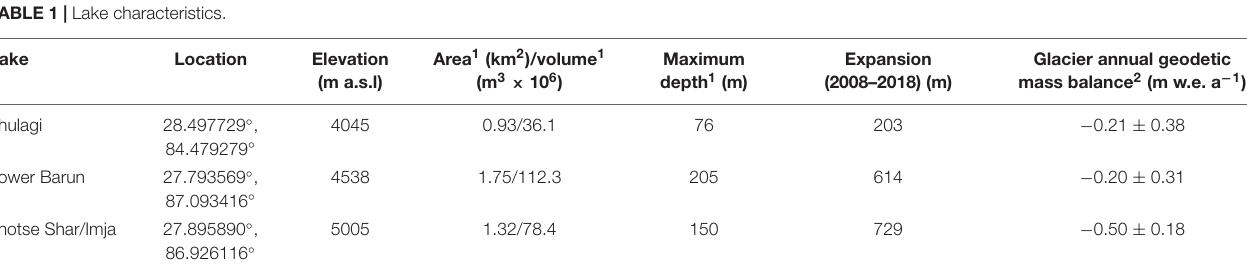
FIGURE 1 | Location of the study glaciers and lakes in Nepal. (A–C) Elevations and hillshades are from the AW3D30 DEM. Debris-covered extents are shown from Kraaijenbrink et al. (2017). The inset has a Natural Earth shaded relief background. TABLE 1 | Lake